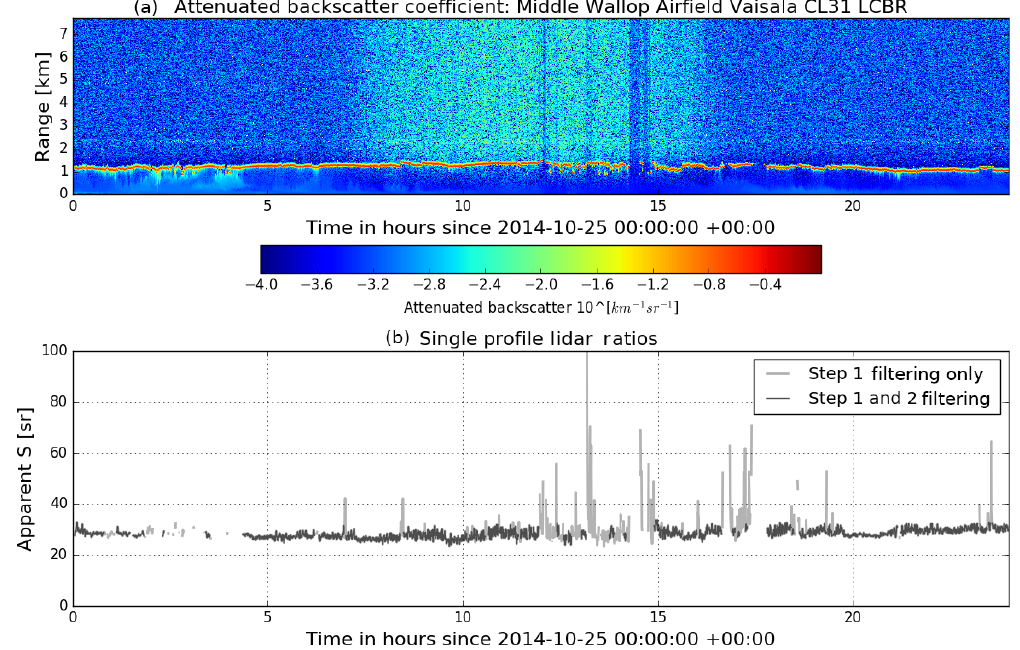
Figure 3. (a) Uncalibrated attenuated backscatter vertical profiles (colours shown on a log scale) for 25 October 2014 from a CL31 ceilometer at Middle Wallop airfield (51.1489 ◦ N, 1.5700 ◦ W) and (b) the apparent lidar ratio for the same day. In (b) , the grey line shows the apparent S for profiles that pass the step 1 filtering of the calibration algorithm and the black line shows the profiles that pass the step 2 filtering and are used to calculate the calibration